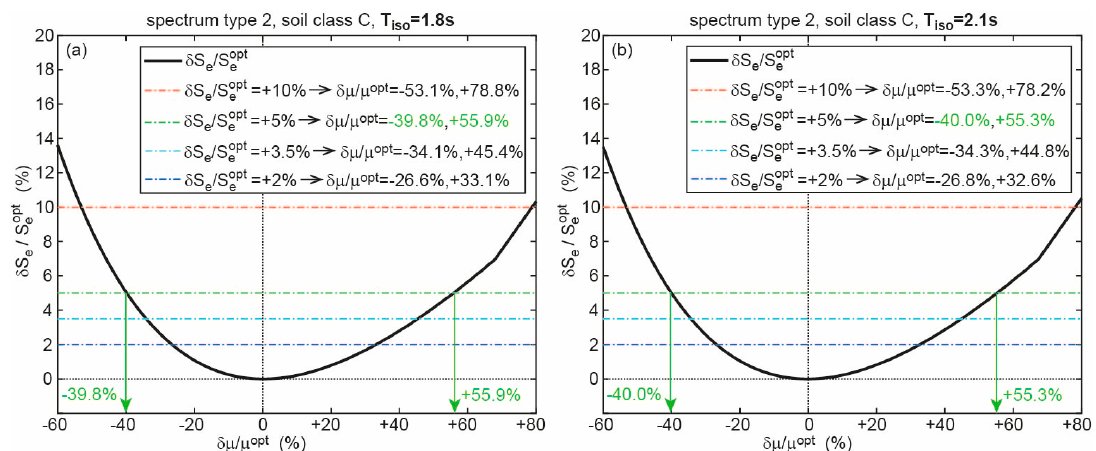
Figure 18. Sensitivity of deviation in friction coefficient from its optimum value on relative increase of structural acceleration for ( a )